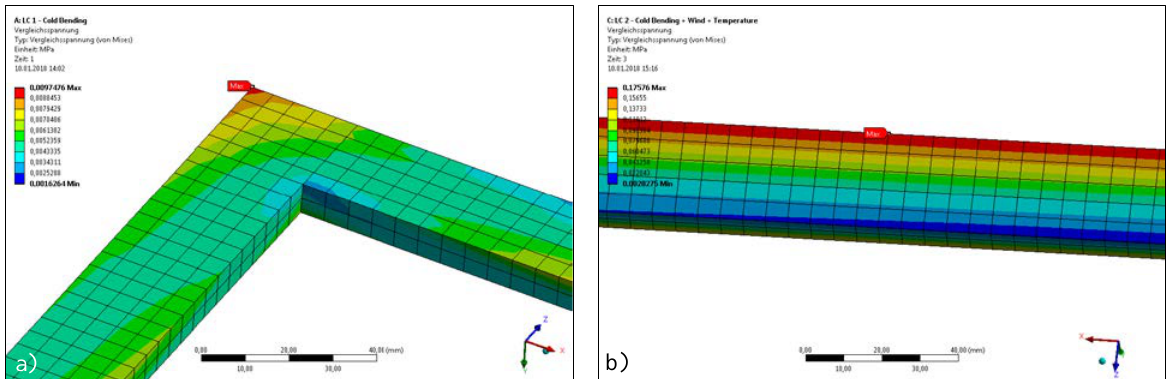
Fig. 13 Influence of stress relaxation on the equivalent stresses (von Mises) in the SG joint: a) LC 1 (cold bending) and b) LC 2 (cold bending + wind +